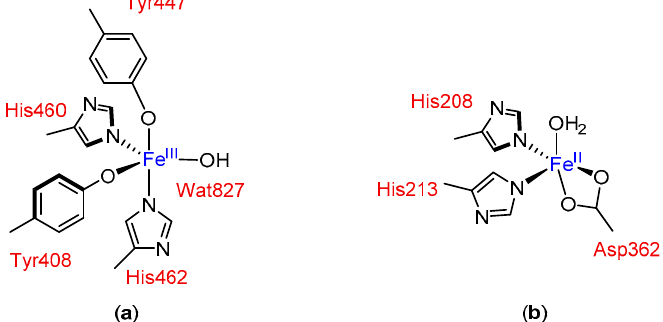
Figure 1. Examplesofactivesitesinnon-hemeironoxygenases: ( a )inprotocatechuate3,4-dioxygenase[13] Figure 1. Examples of active sites in non-heme iron oxygenases: ( a ) in protocatechuate 3,4-dioxygenase and ( b ) in naphthalene dioxygenase [13] and ( b ) in naphthalene dioxygenase [14,15].